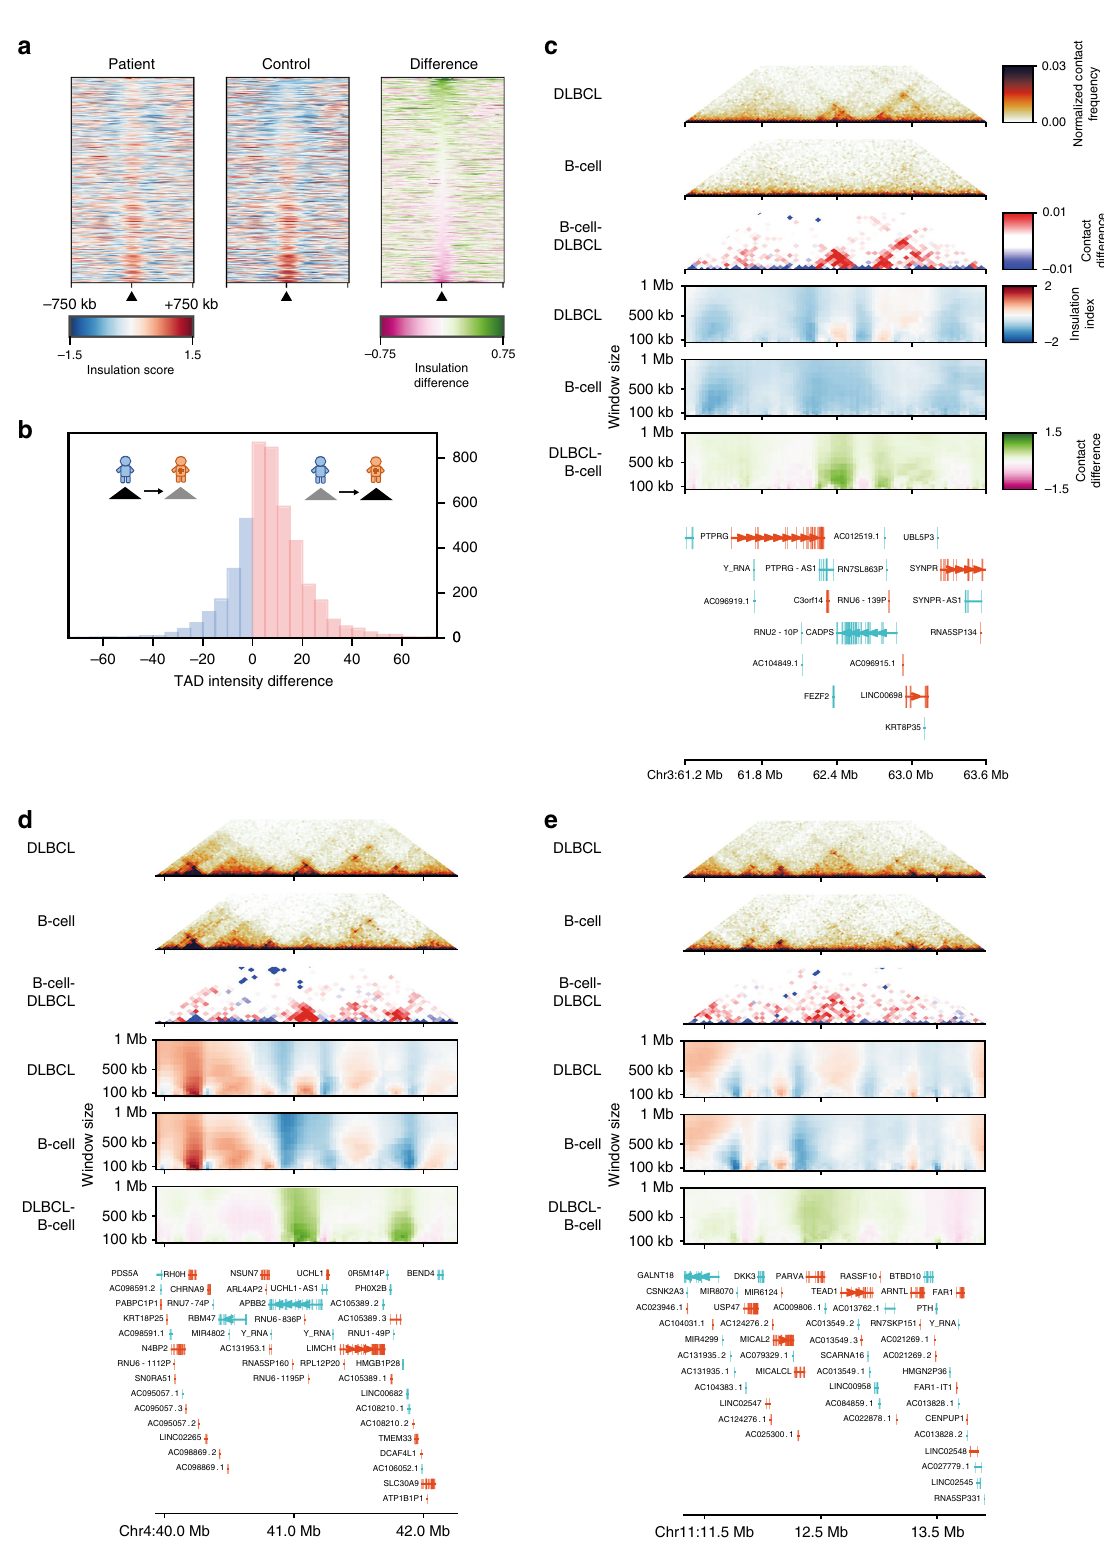
Fig. 6 Extensive rewiring of chromatin organisation in DLBCL cells. a Insulation score changes between DLBCL (patient) and B-cell (control) for all regions in-between two consecutive TAD boundaries (centre marked by triangle). b Histogram of the differences in average Hi-C signal between two consecutive TAD boundaries from patient to control. c – e Examples of de novo TADs emerging in DLBCL showing (from top to bottom: Local DLBCL Hi-C, local B-cell Hi-C, difference in local Hi-C (DLBCL – B-cell), insulation scores for different window sizes in DLBCL, insulation score in B-cell, difference in insulation score (DLBCL – B-cell), genes in the region